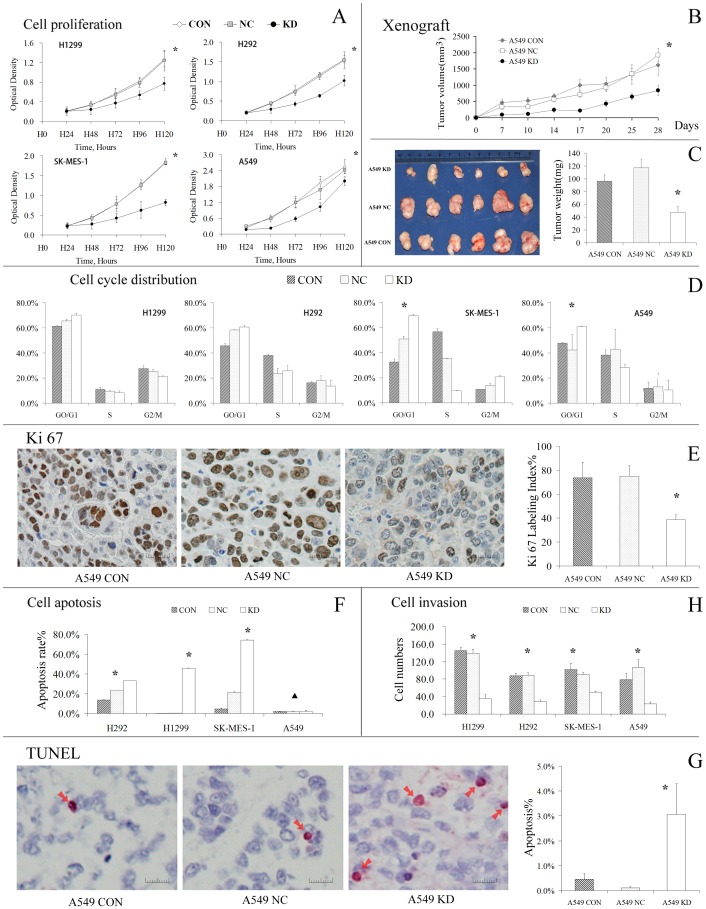
The inhibition of GSK3β attenuates cell proliferation, induces apoptosis, arrests cells in GO/G1 phase and increases cell invasiveness.(A) The CCK-8 test showed that the inhibition of GSK3β suppressed the proliferation of the NSCLC cell lines in vitro. *P<0.001. (B) In vivo: As described in Figure 3C, the xenograft models were developed in nude mice. Each group consisted of 6 animals. Tumors were observed every 3 days for 4 weeks. The xenograft tumors of mice in the KD group grew significantly slower (as determined by the tumor volume) over the entire observation period. *P<0.001. (C) Comparison of the isolated xenograft tumors. The image shows that tumors isolated from the KD group were smaller and lighter than the tumors from the control group. The data are expressed as the means ± SD, n = 6. *P<0.001. (D) Representative image of Ki-67 IHC of a tumor xenograft viewed under a microscope. To calculate the Ki-67 LI, cells with brown-stained nuclei were considered positive, indicating active proliferation (magnification × 400). The data are expressed as the means ± SD, *P<0.001. (E) Cell cycle analysis at 72 h after transfection. The results suggest that the inhibition of GSK3β resulted in G1/S arrest in A549 and SK-MES-1 cells and changed the proportions of the cell population in different phases of the cell cycle. The data are presented as the means ± S.D. from 3 independent experiments performed in triplicate. *P<0.001. (F) By flow cytometry, the apoptotic analysis results indicated that the inhibition of GSK3β greatly increased the apoptotic rate of NSCLC cells (except for A549 cells) in vitro. *P<0.001, ▴P>0.05. (G) The results of the TUNEL assay for xenograft tumors suggested that the inhibition of GSK3β increased the apoptotic rate of A549 cells in vivo (magnification × 400). The data are expressed as the means ± SD, *P<0.001. (H) Transwell assays showing that the inhibition of GSK3β in vitro significantly decreased the invasiveness of NSCLC cells. The data are expressed as the means ± S.D. *P<0.001.